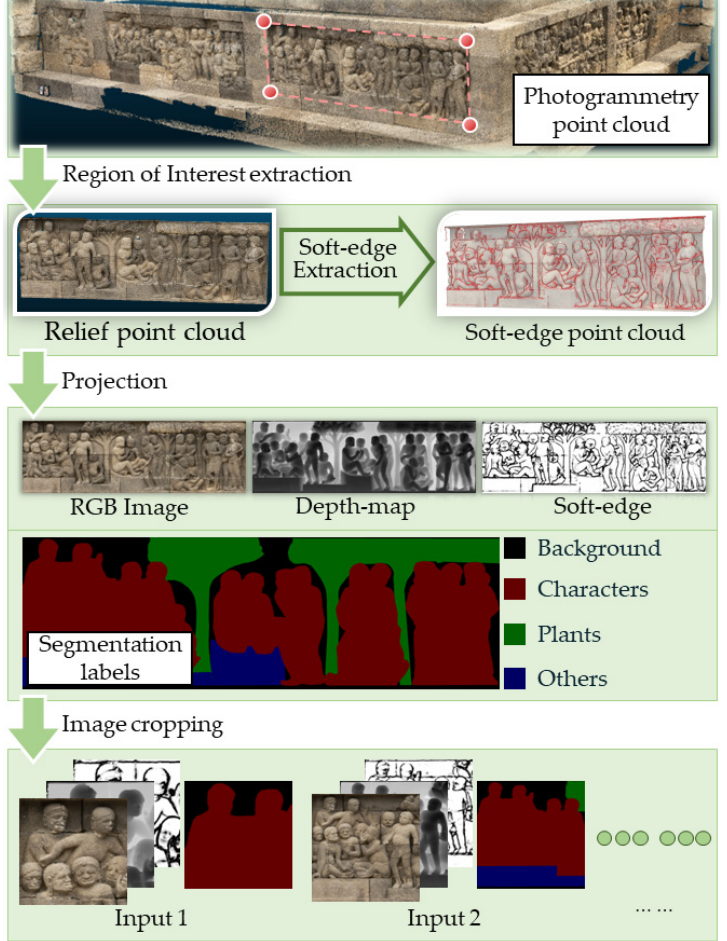
Figure 8. Block diagram of dataset creation.